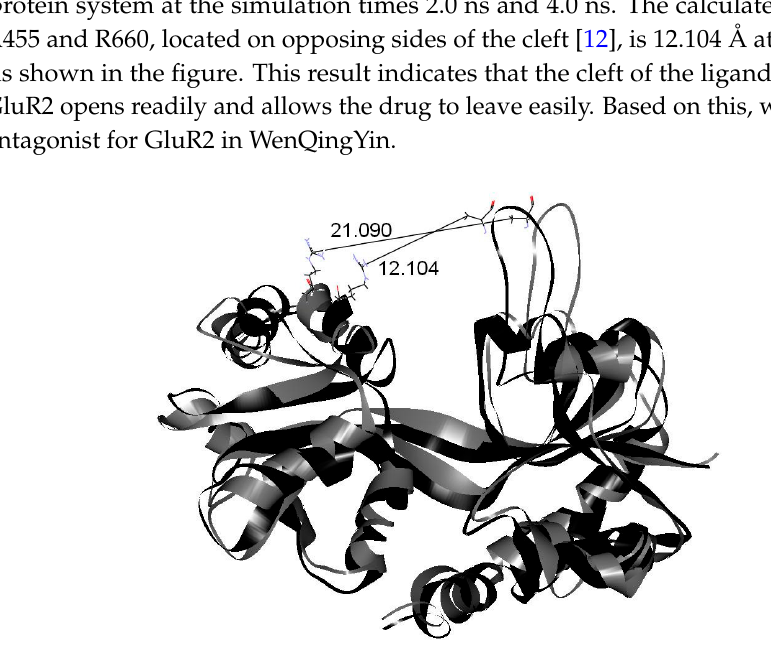
Figure 10. The backbone of GluR2 in cerbinal system at 2.0 ns and 4.0 ns. The black line is 2.0 ns and the gray line is 4.0 ns. The distance between A455 and R660 is shown.